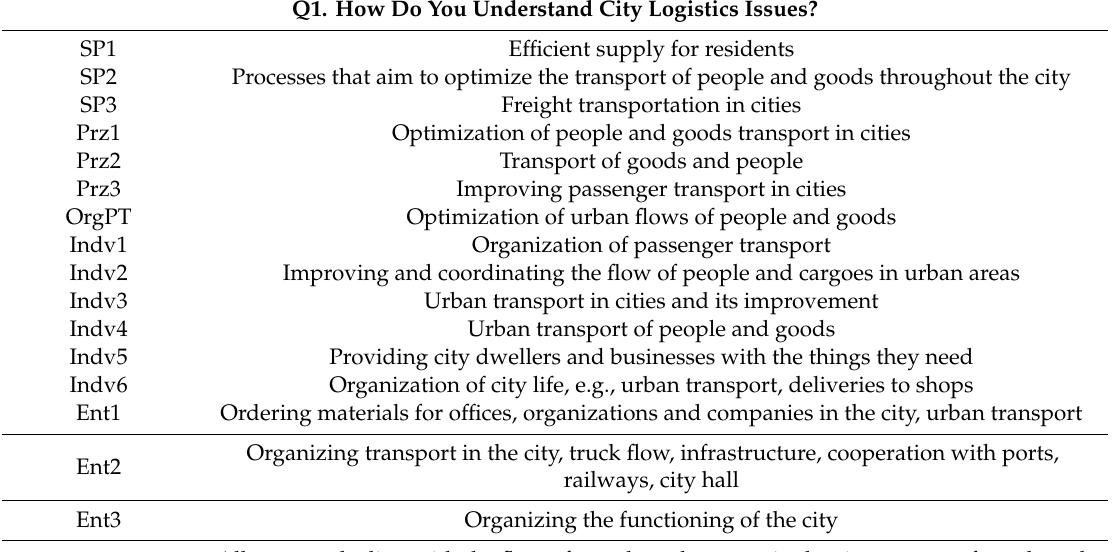
Table A2. Respondents responses